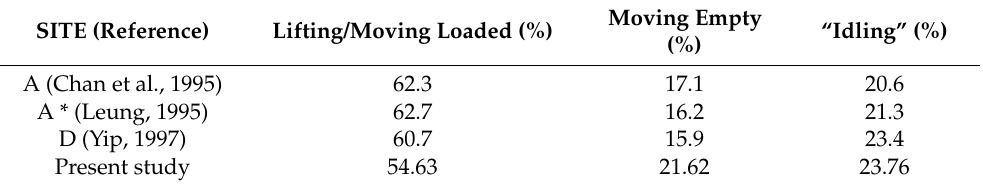
Table 1. Average utilization profiles of tower cranes (adapted from * Kumaraswany, 1997). SITE (Reference) Lifting/Moving Loaded (%)